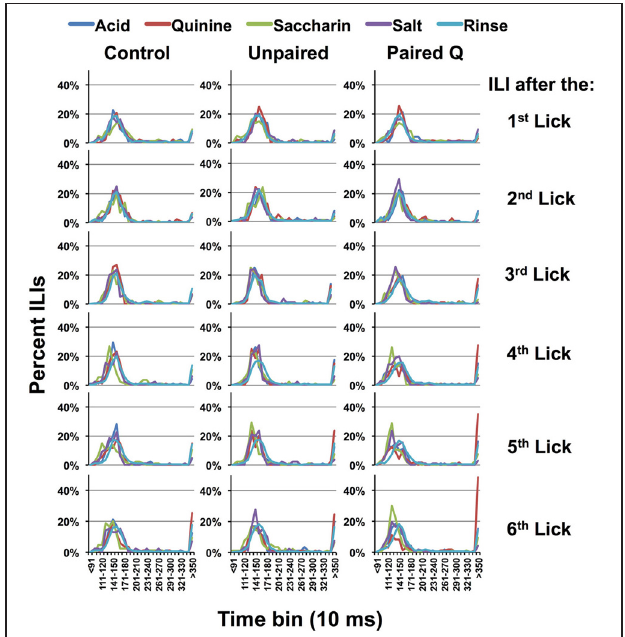
FIGURE 2 | Interlick interval timing. Interlick interval (ILI) distribution following three reinforced stimulus presentations, normalized according to the total number of ILIs. Each panel shows the distribution of ILIs following each of six licks, beginning with the first lick of the three-lick stimulus sequence; i.e., the first 3 ILI’s in the three-lick paradigm follow quinine delivery whereas the later ILI’s are dry licks. Bin = 10ms. Results show that rats will lick consistently for all taste stimuli until ILI-4. For ILI-4 and -5, ILIs become longer for